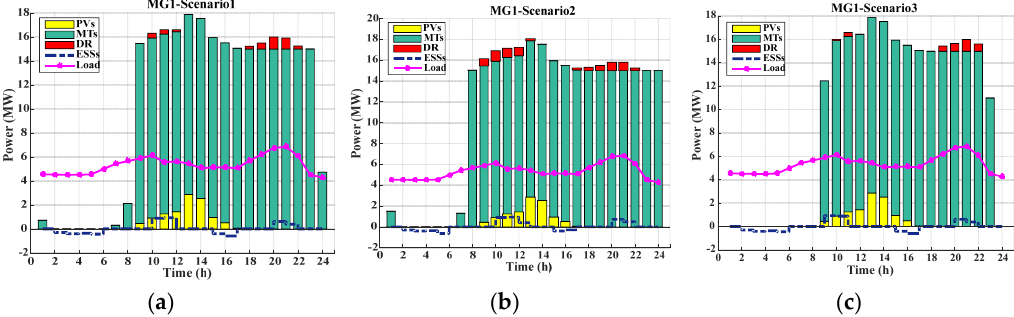
Figure 6. Hourly operation scheduling of the MTs, DR programs and ESSs in MG1 for CS1: ( a ) scenario 1; ( b ) scenario 2; ( c ) scenario 3.